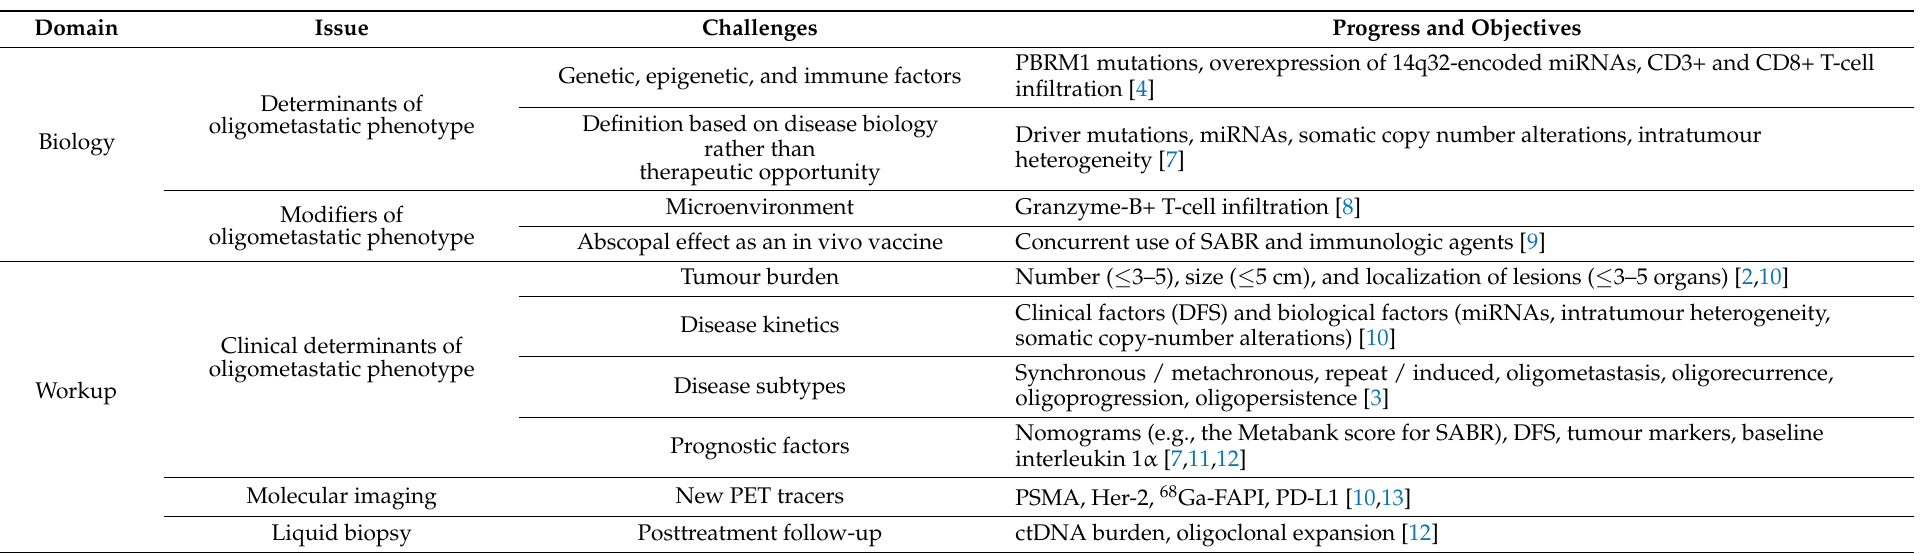
Table 1. An overview of key concepts and research opportunities in oligometastatic